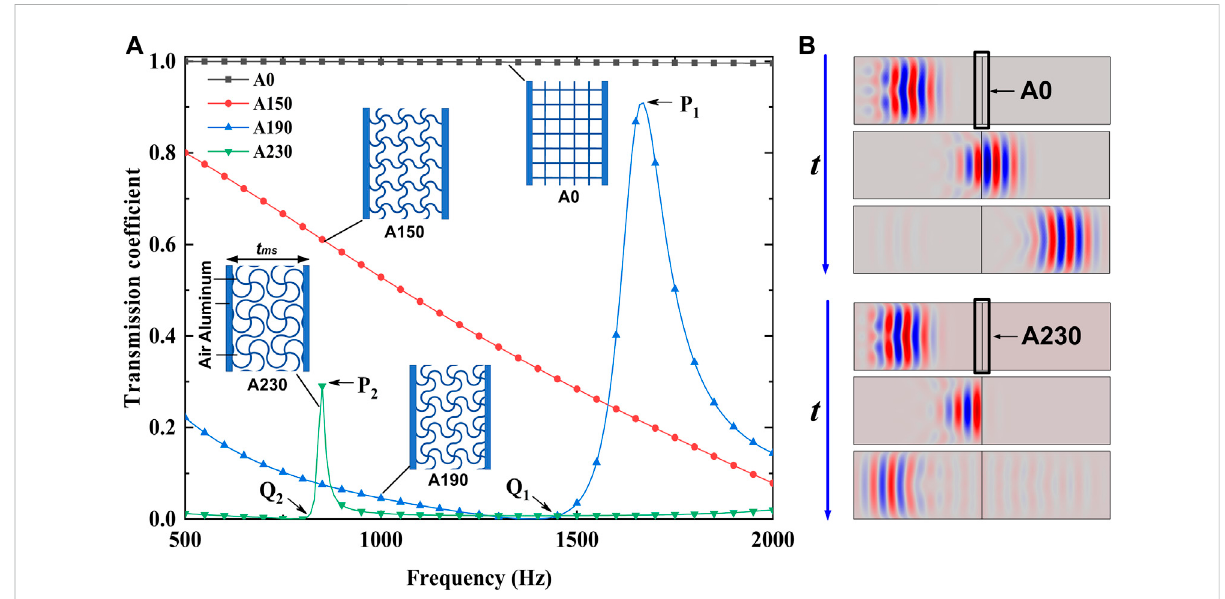
chiral structures with central angles of φ (cid:1) 0 ° , 150 ° , 190 ° , and 230 ° , respectively. Note that the A0 metascreen, which consists of a square honeycomb lattice, is not strictly chiral and is included for comparison. Table 1 lists the speci fi c structural parameters of the metascreens. All metascreens have the same overall thickness t ms (cid:1) 32 . 52 mm